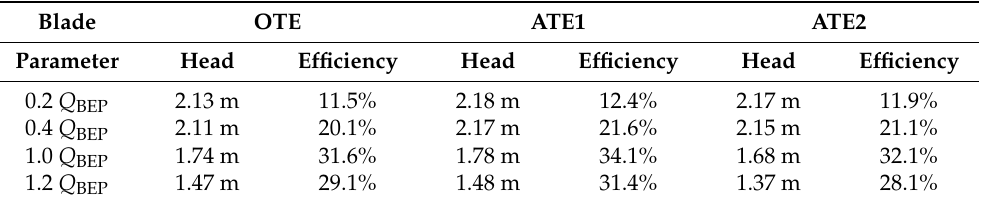
Table 2. Performances of different model pumps at four flow rates.